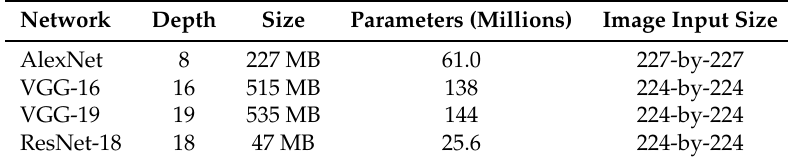
Table 2. Parameters and dimensions of pre-trained CNNs used